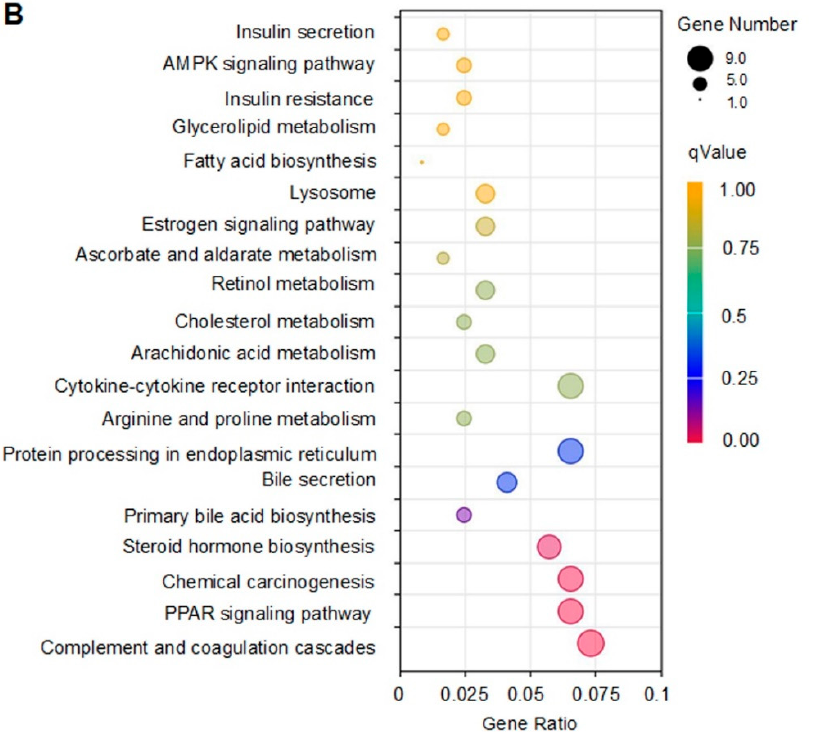
Figure 4. GO and KEGG pathway enrichment analysis of DEGs. ( A ) GO annotation and classification based on biological process (BP), cellular component (CC), and molecular function (MF). ( B ) KEGG enrichment bubble chart. The color of the point indicates the q-value of the hypergeometric test, and the size represents their corresponding number of genes in their pathway.